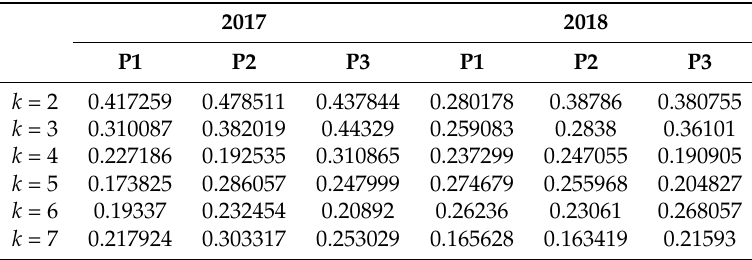
Table 6. Silhouettes’ average